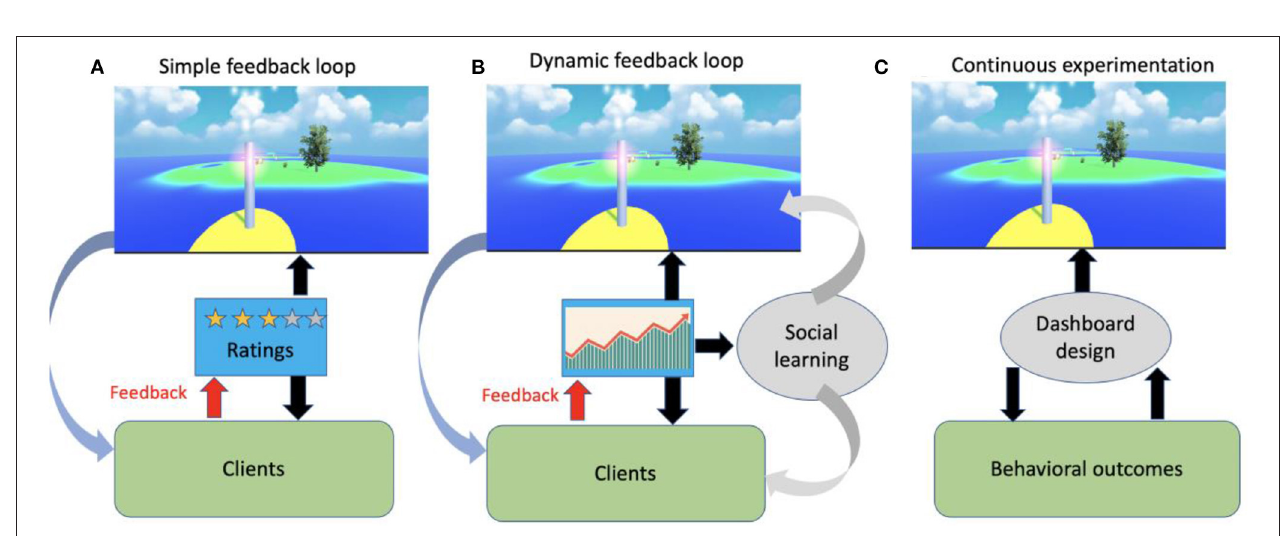
FIGURE 4 | From rating systems to governance evolution. (A) A FSG experiment with a typical online rating system, where both service provider (e.g., restaurant) and client’s behaviors are guided by feedback ratings. (B) Replacing rating scores with a dashboard presenting trends to promote social learning in FSG experiment. (C) A framework for ongoing experimentation with dashboard